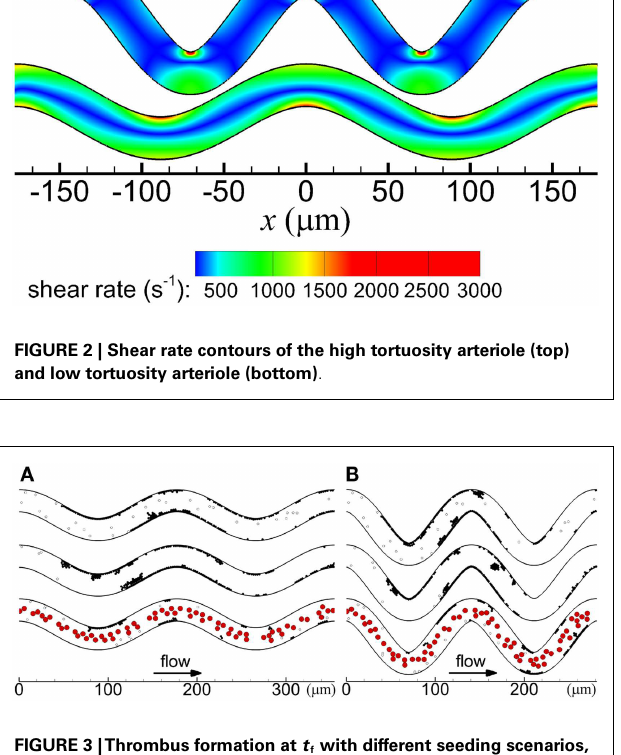
tortuosity arteriole ( ∼ 0.6 s) than in the low tortuosity arteriole ( ∼ 0.2 s). However, after this short time, activation count became smaller with RBCs compared to near-wall-seeded platelets with- out RBCs. Due to the higher seeding rate with whole-lumen- seeded platelets, activation count for this seeding scenario became larger than the near-wall-seeded platelets scenario and the RBCs with platelets scenario for both tortuous arterioles, as shown in Figure 4C for the high tortuosity arteriole. The low tortuosity arteriole showed similar results to those in Figure 4C , except that activation counts at the final time were slightly smaller at 623, 517, and 462, with whole-lumen-seeded platelets, near-wall- seeded platelets, and RBCs with platelets, respectively. These same values for the high tortuosity arteriole were 654, 532, and 490. However, activation percent was lowest at most times with whole- platelets near the center of the